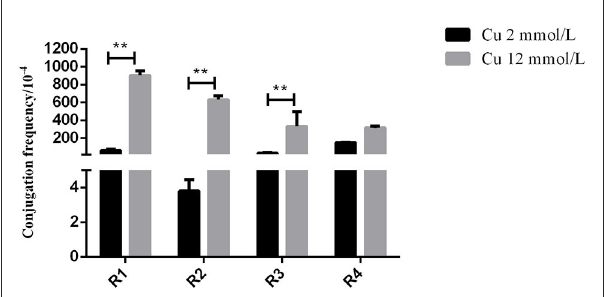
FIGURE2 The effects of different copper levels on conjugation frequency. Error bars represent standard error of the means. **means P < 0.01.